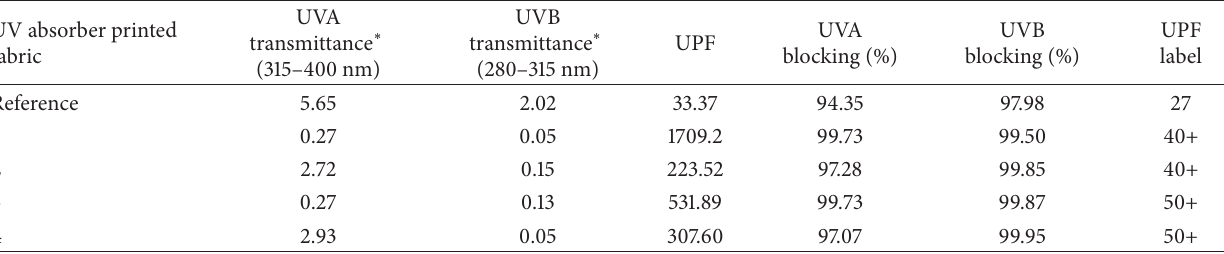
Table 2: UV protective features of absorbers.